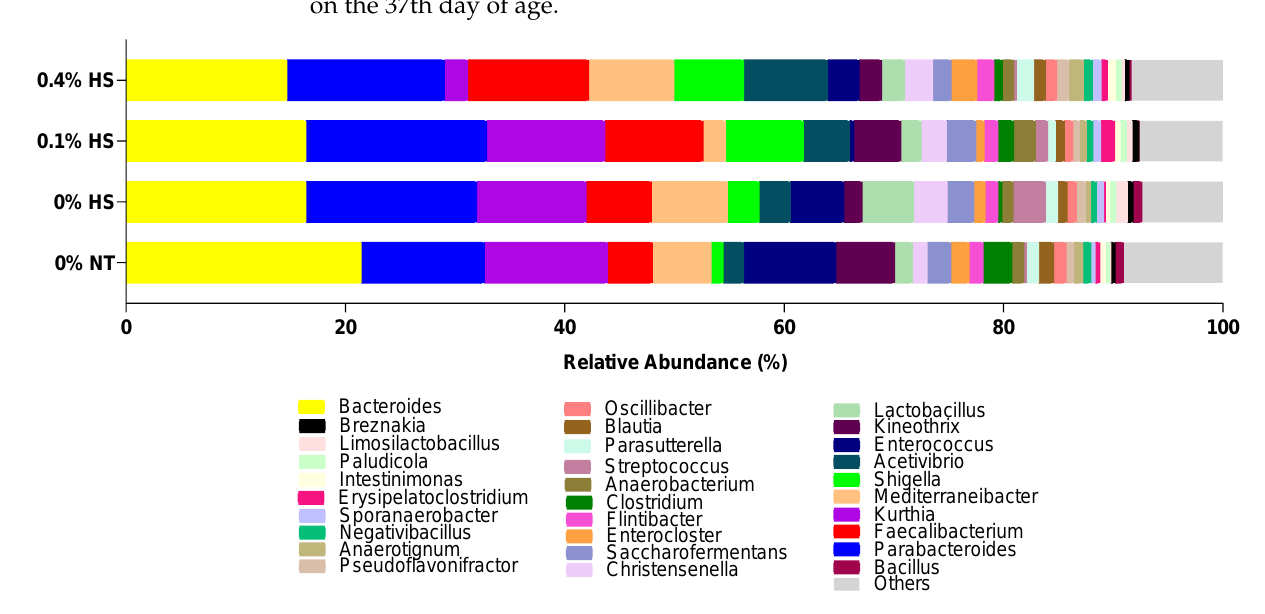
Figure 6. Effects of supplementing diets with solubles from shredded, steam-exploded pine particles (SSPPs) on the cecum microbial profiles of bacterial genera when broiler chickens were exposed to either thermoneutral or heat-stress conditions. Chickens were fed with diets containing 0% (control), 0.1%, and 0.4% SSPPs from the 8th day to the 36th day of age. On the 37th day, birds were either kept at thermoneutral temperature (21.0 °C) and provided a control diet (0% NT) or heat-stressed at 31.0 °C for six hours and provided a diet supplemented with 0% (0% HS), 0.1% (0.1% HS), or 0.4% (0.4% HS) SSPPs. Data show means (n = 6). Abbreviations: NT, normal temperature; HS, heat stress.